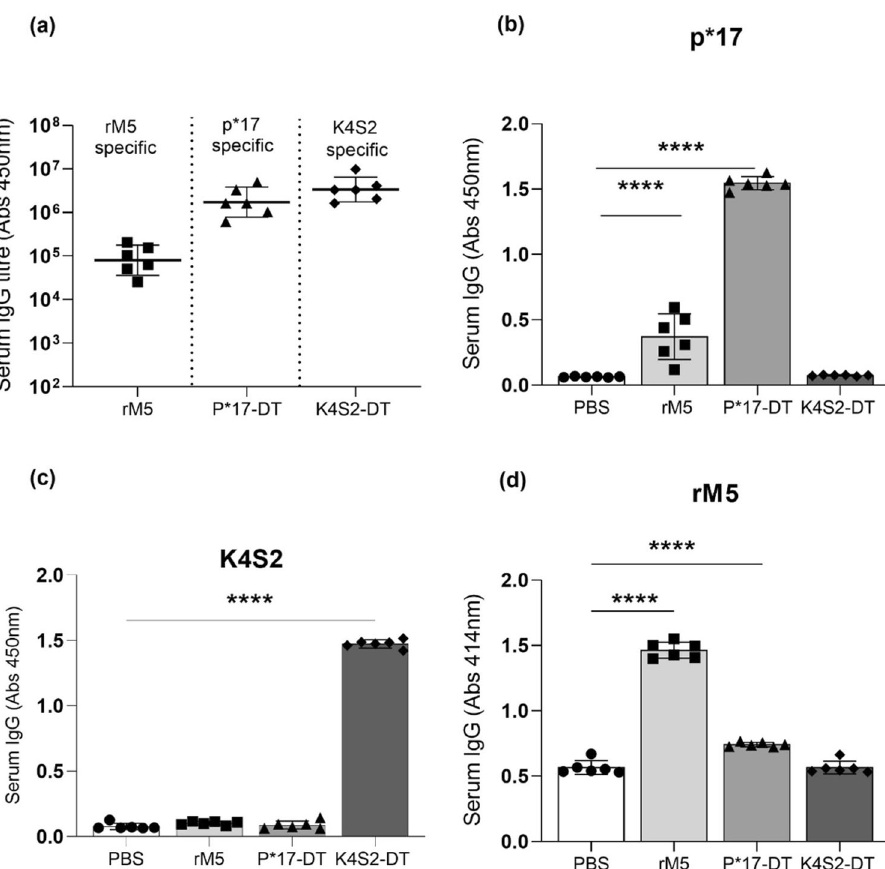
Fig. 3 Antibody responses to speci fi c antigen. Antigen-speci fi c serum IgG titres ( a ) and serum IgG reactivity in rats administered with PBS ( (cid:129) ), rM5 ( ▪ ), P*17-DT ( ▴ ) or K4S2-DT ( ♦ ) to peptide p*17 ( b ), peptide K4S2 ( c ) and rM5 ( d ). Absorbance values of day-35 rat sera at 1:400 ( b , c ) and 1:100 ( d ) is shown. IgG titres were de fi ned as the highest dilution of serum for which OD was >3 standard deviations above the mean OD of PBS control at highest dilution. Statistical analysis performed by one-way ANOVA with Dunnett multiple comparison test. Signi fi cance to PBS control group, * P < 0.05, ** P < 0.01, *** P < 0.001 and **** P < 0.0001. Error bars represent standard